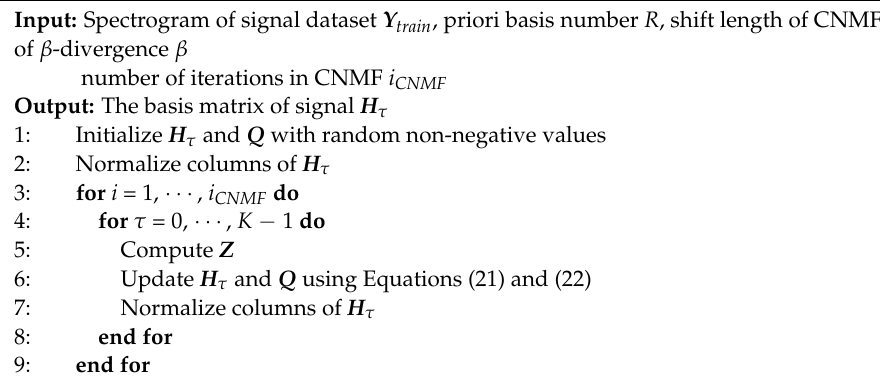
Algorithm 1. Signal basis training using CNMF